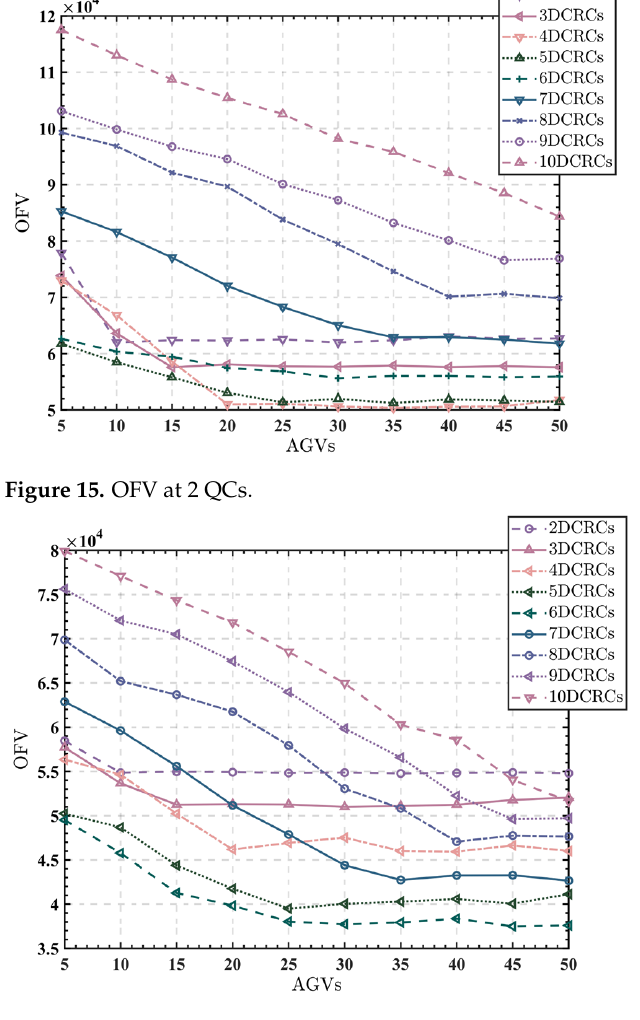
Figure 14. OFV at 1 QC.